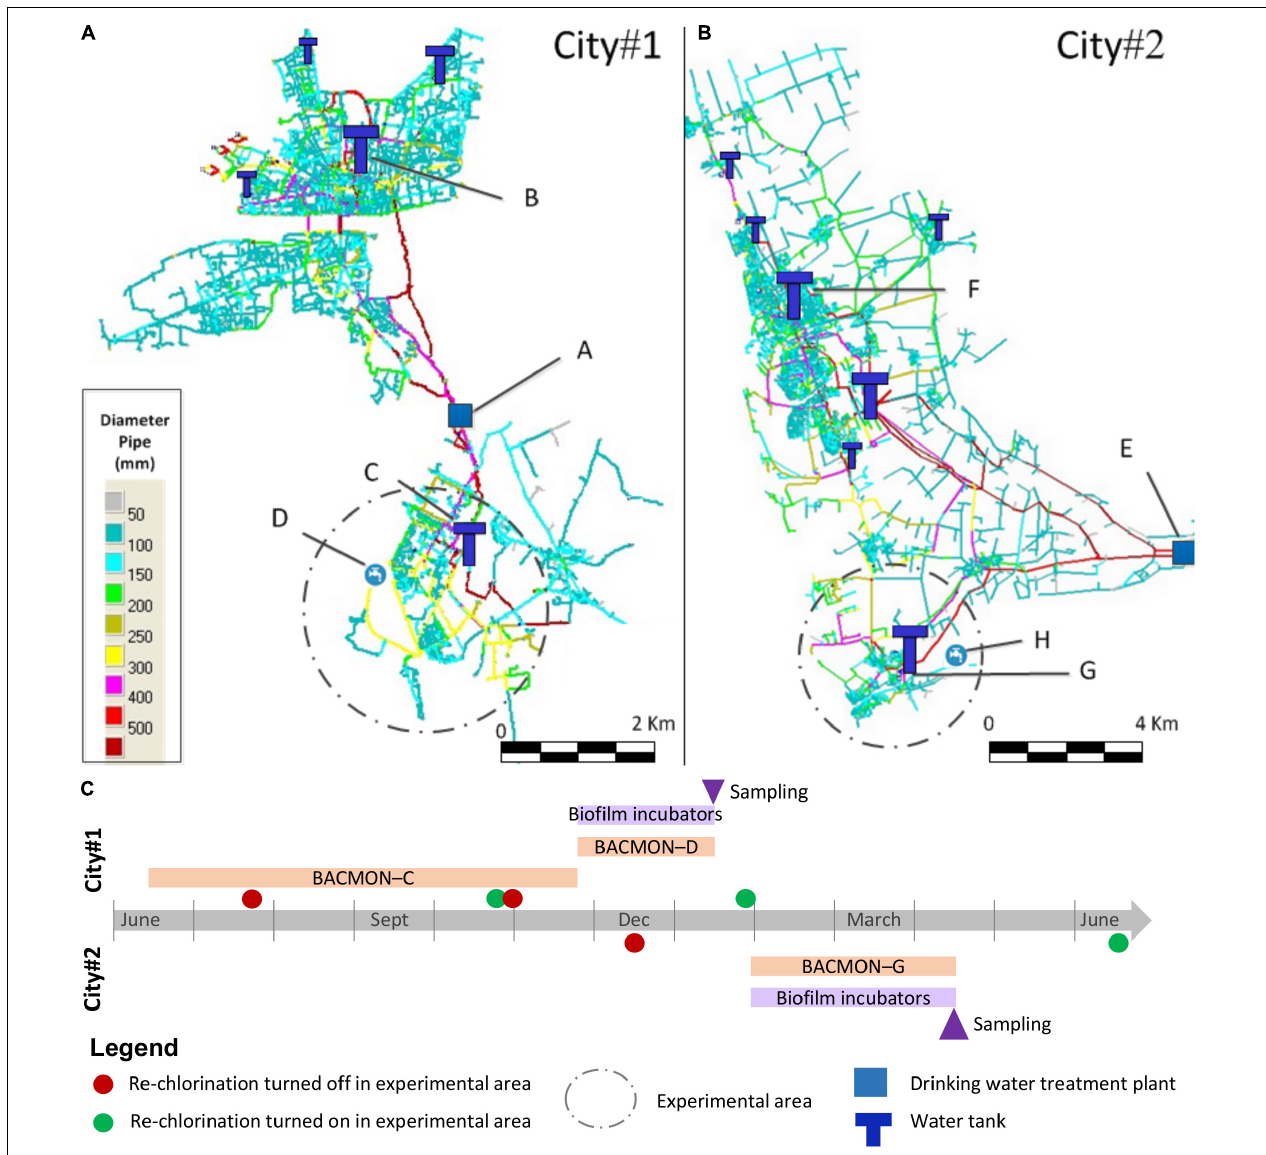
FIGURE 1 | Experimental design and drinking water distribution systems. The drinking water distribution systems (DWDS) of City#1 (A) and City#2 (B) comprised an experimental zone (dashed circle) where residual chlorine concentration was minimized by turning off the re-chlorination station (C) . Four biofilm incubators where added at the outlet of the drinking water treatment plants and in the water network of each city. Biofilms A and E were recovered at the DWTP outlet, B and F downstream a drinking water tank with a rechlorination system, C and G downstream a drinking water tank without chlorine injection, and D and H in the distribution network. Biofilms were recovered after 8 and 10 weeks incubation for City#1 and City#2, respectively. A BACMON online sensor was set-up prior to the experiment in point C, and during the biofilm formation on points D and G.